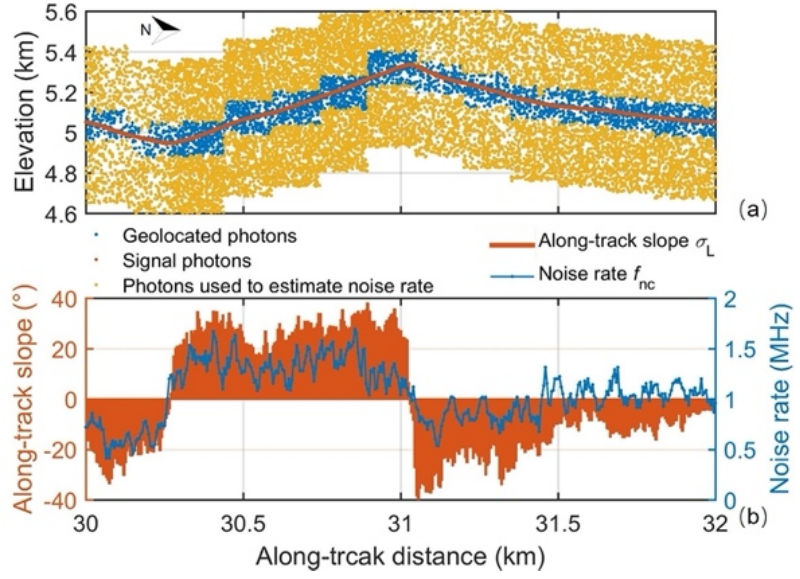
Figure 6. ( a ) Sampled along-track segment from the ICESat-2 strong beam in the first study area (i.e., ATL03_20181207065658_10640102_002_01, GT1R). The x -axis represents relative ICESat-2 along-track distance and the y -axis represents the ellipsoid height in kilometers. The measured geolocated photons marked with red are the detected signal photons. The geolocated photons marked with yellow are used to estimate the noise rate f nc in every along-track segment. The total extent of the vertical window was approximately 800 m in the current data, and the elevation of the top of the vertical window was H top and the elevation of the bottom of the vertical window was H bottom . The yellow points correspond to noise photons within the vertical range of [ H top -300 m, H top ] and [ H bottom , H bottom + 300 m]. ( b ) The along-track slope σ L versus the background noise rates f nc at different along-track distances. Measured noisy geolocated photons of the whole ground track in Figure 6a were divided into a 20-m along-track segment with a step size of 5 m. As shown in Figure 6a, the spatial density of noise photons on the adret slope (from 30.5 to 31 km) was much denser than that on the ubac slope (from 31 to 31.5 km). The results in Figure 6b indicate that the background noise rate on the adret slope was approximately two times larger than that on the ubac slope in steep areas, where the slope was larger than 10 ◦ . When the along-track slope was smaller than 10 ◦ , the difference in noise rates was relatively small. Based on the phenomenon in Figure 6, the empirical equations between the surface slope and the noise rate have to be separately established for the adret and ubac sides. In this study, a cubic polynomial was used to represent the empirical